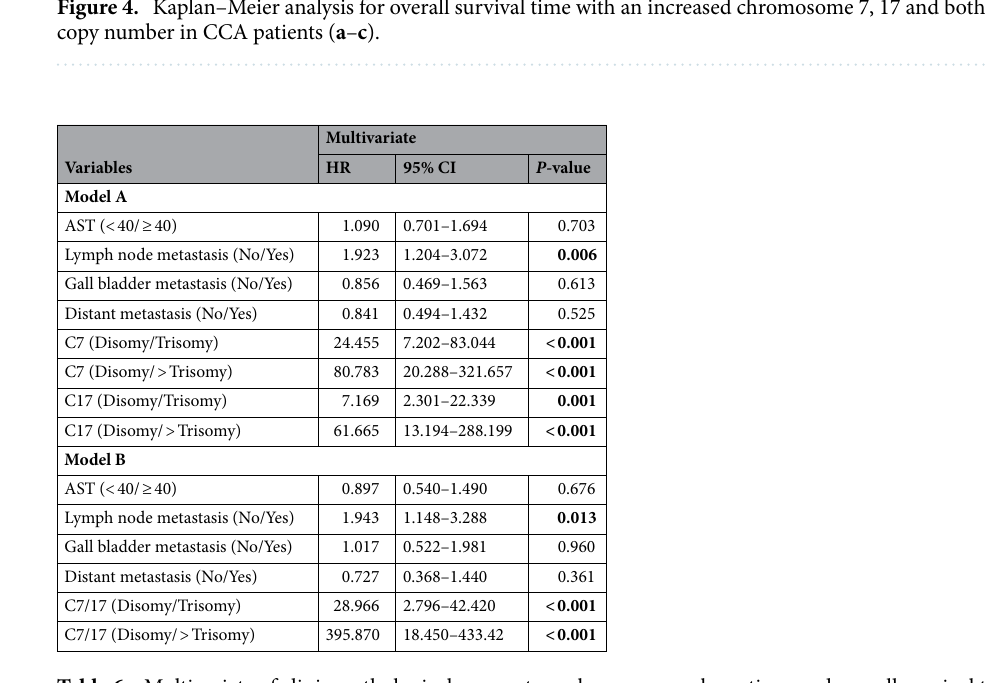
Table 6. Multivariate of clinicopathological parameters, chromosome aberrations and overall survival